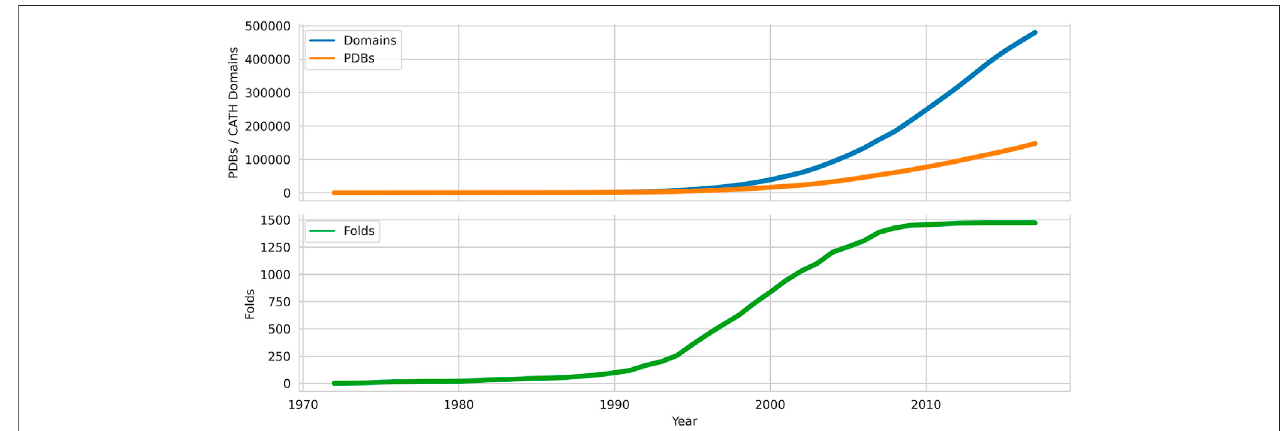
FIGURE 1 | Growth of domains, folds and chains deposited in the Protein Data Bank from 1972 onwards. Data sources: PDB,